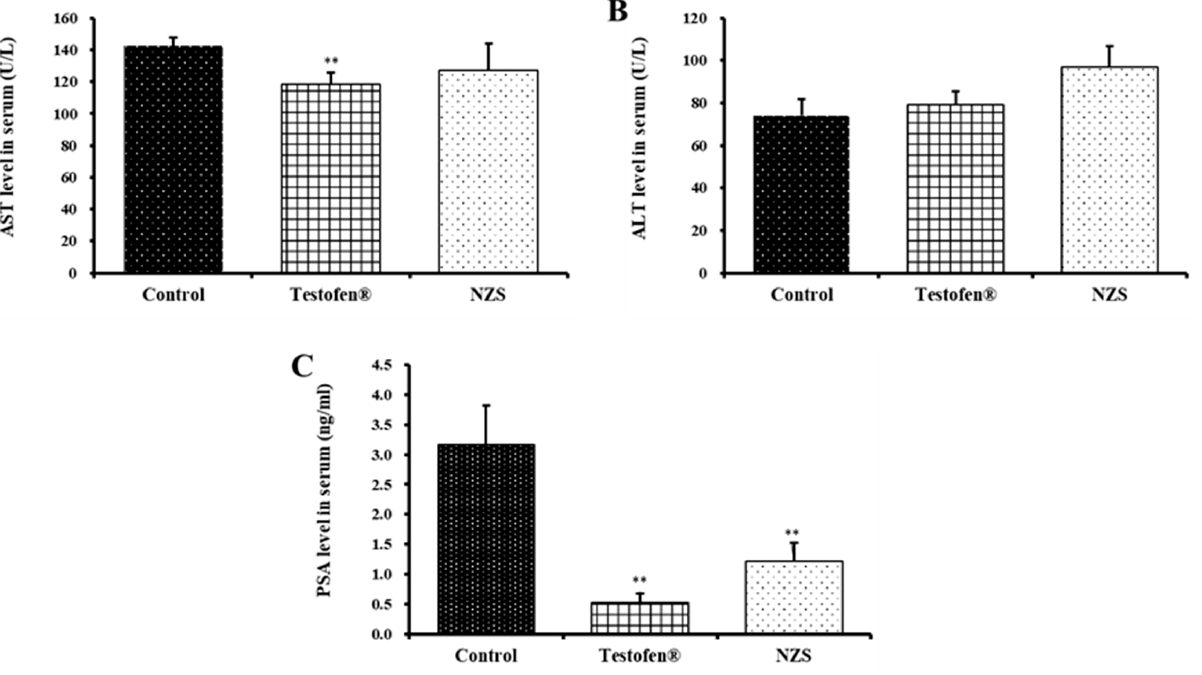
Figure 5. Comparative analysis of serum levels of aspartate aminotransferase (ALT) ( A ), alanine aminotransferase (AST) ( B ), and prostate-specific antigen (PSA) ( C ) after NZS extract administration for four weeks. Data are expressed as means ± standard error (n = 5). A symbol of ** denotes significant difference compared to aged rat (control) at p < 0.01 level.